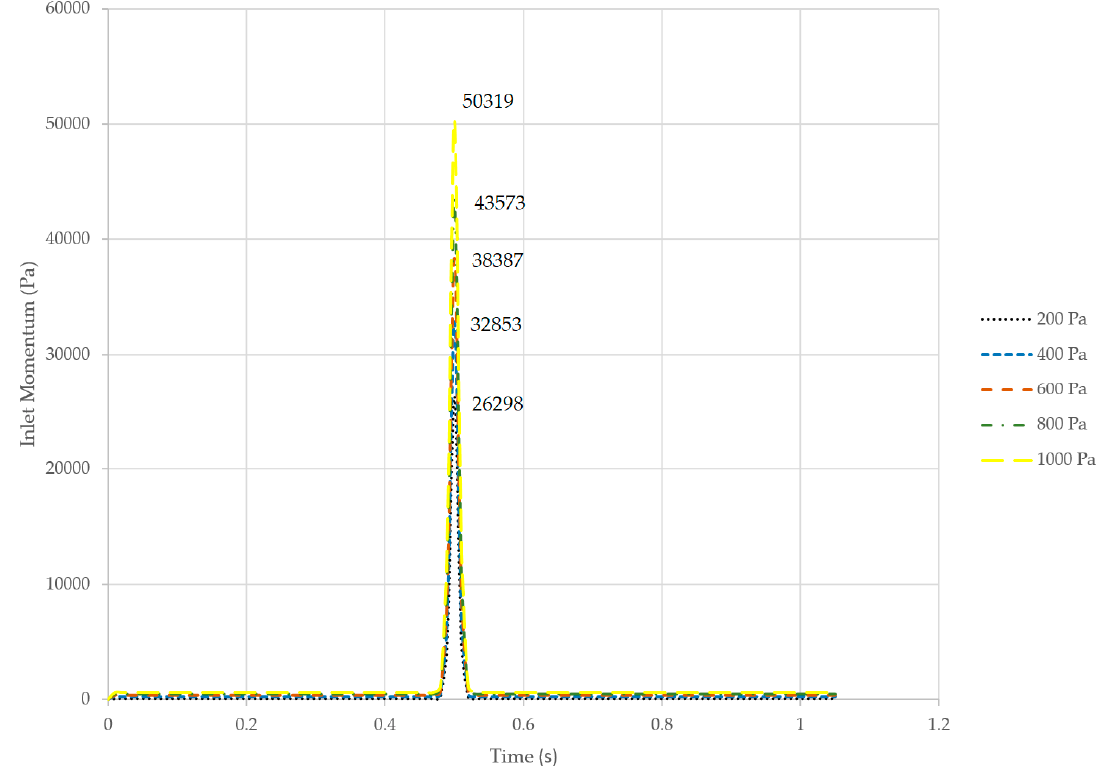
Figure 17. Amplification of inlet momentum due to the liquid slug of the hydraulic jump.